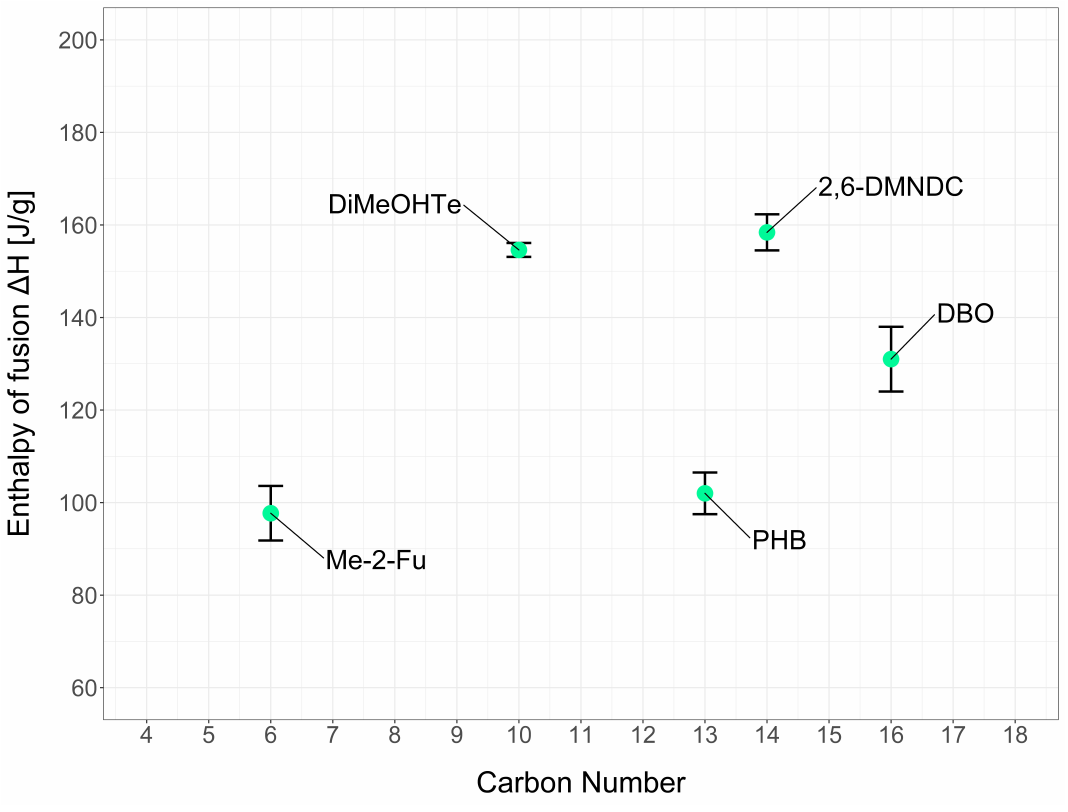
Figure 3. Scatter plot of the average enthalpies of fusion ( ∆ H , green circle) plotted against the carbon numbers (Carbon Number). The error bars represent the standard deviation between the means of three measurements for each compound. The aromatic esters for which the phase change temperatures could not be determined do not appear in the plot. The ∆ H of aromatics esters are low to medium and reach maximum values of 158.4 J/g for 2,6-DMNDC while a minimum of 97.7 J/g is measured for Me-2-Fu. The ∆ H seemingly increases for increasing Carbon Nr, with the exception of PHB and